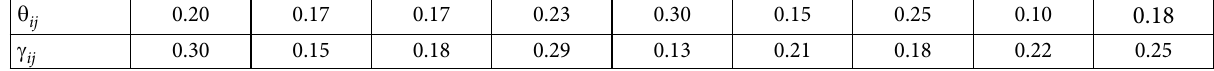
Table 8. Depreciation rate in profit and increment rate in